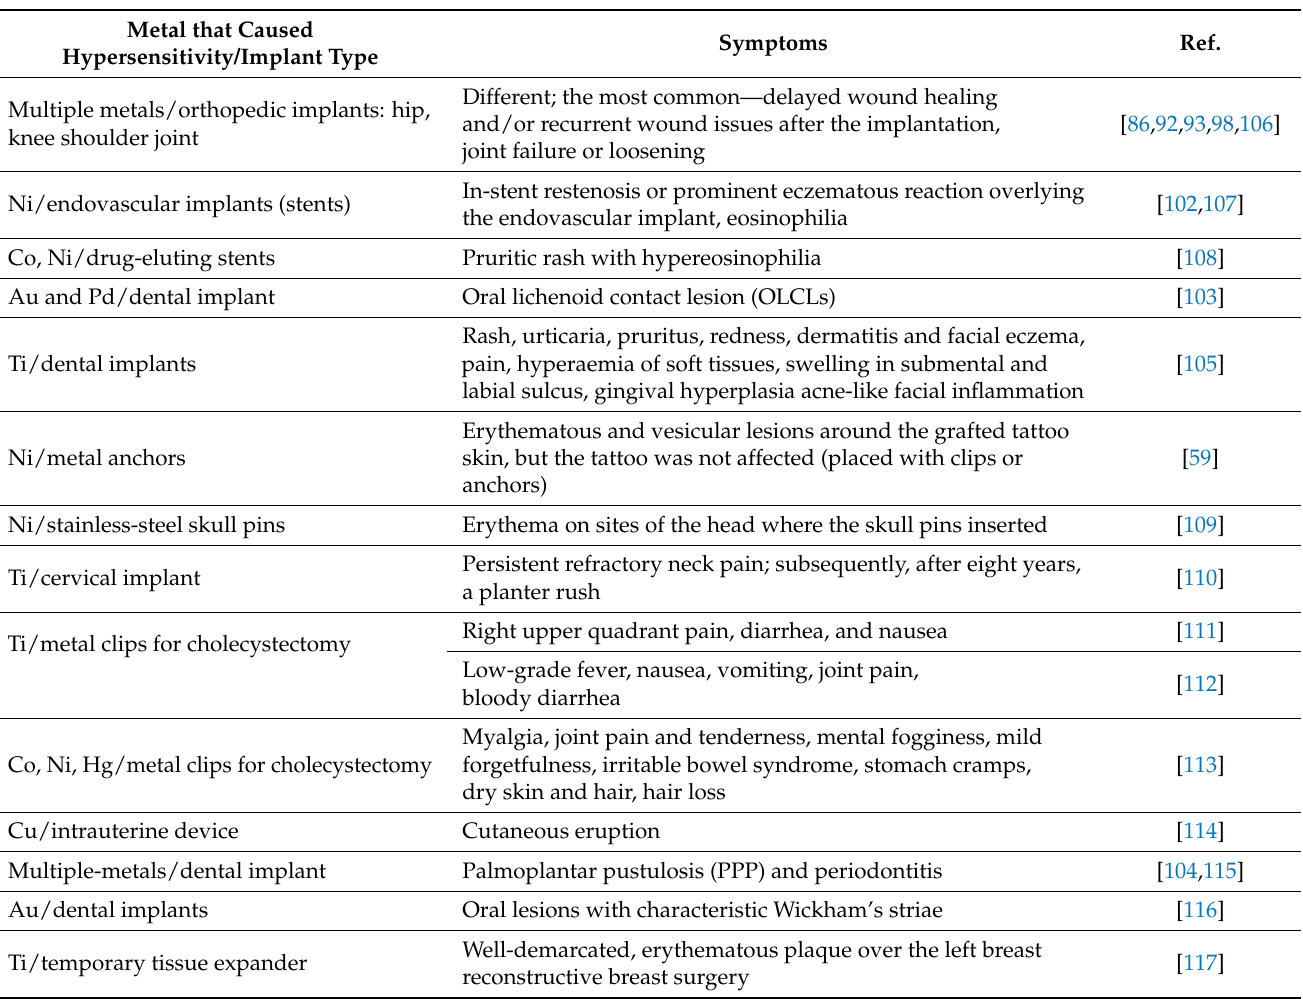
Table 2. Advances on hypersensitivity to medical implants, including unusual